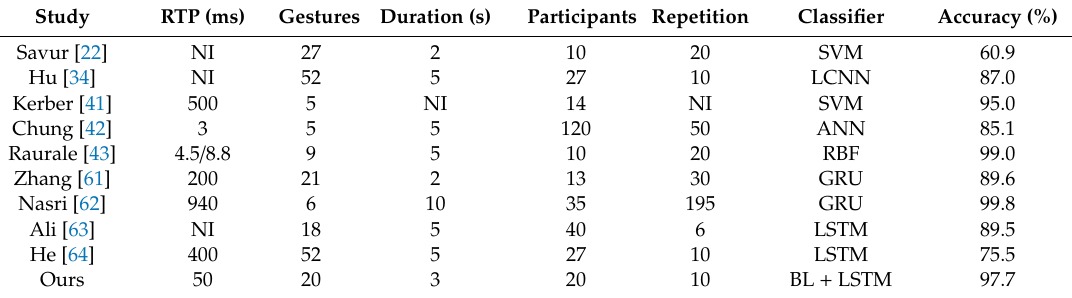
Table 10. Comparison with other studies using a Myo